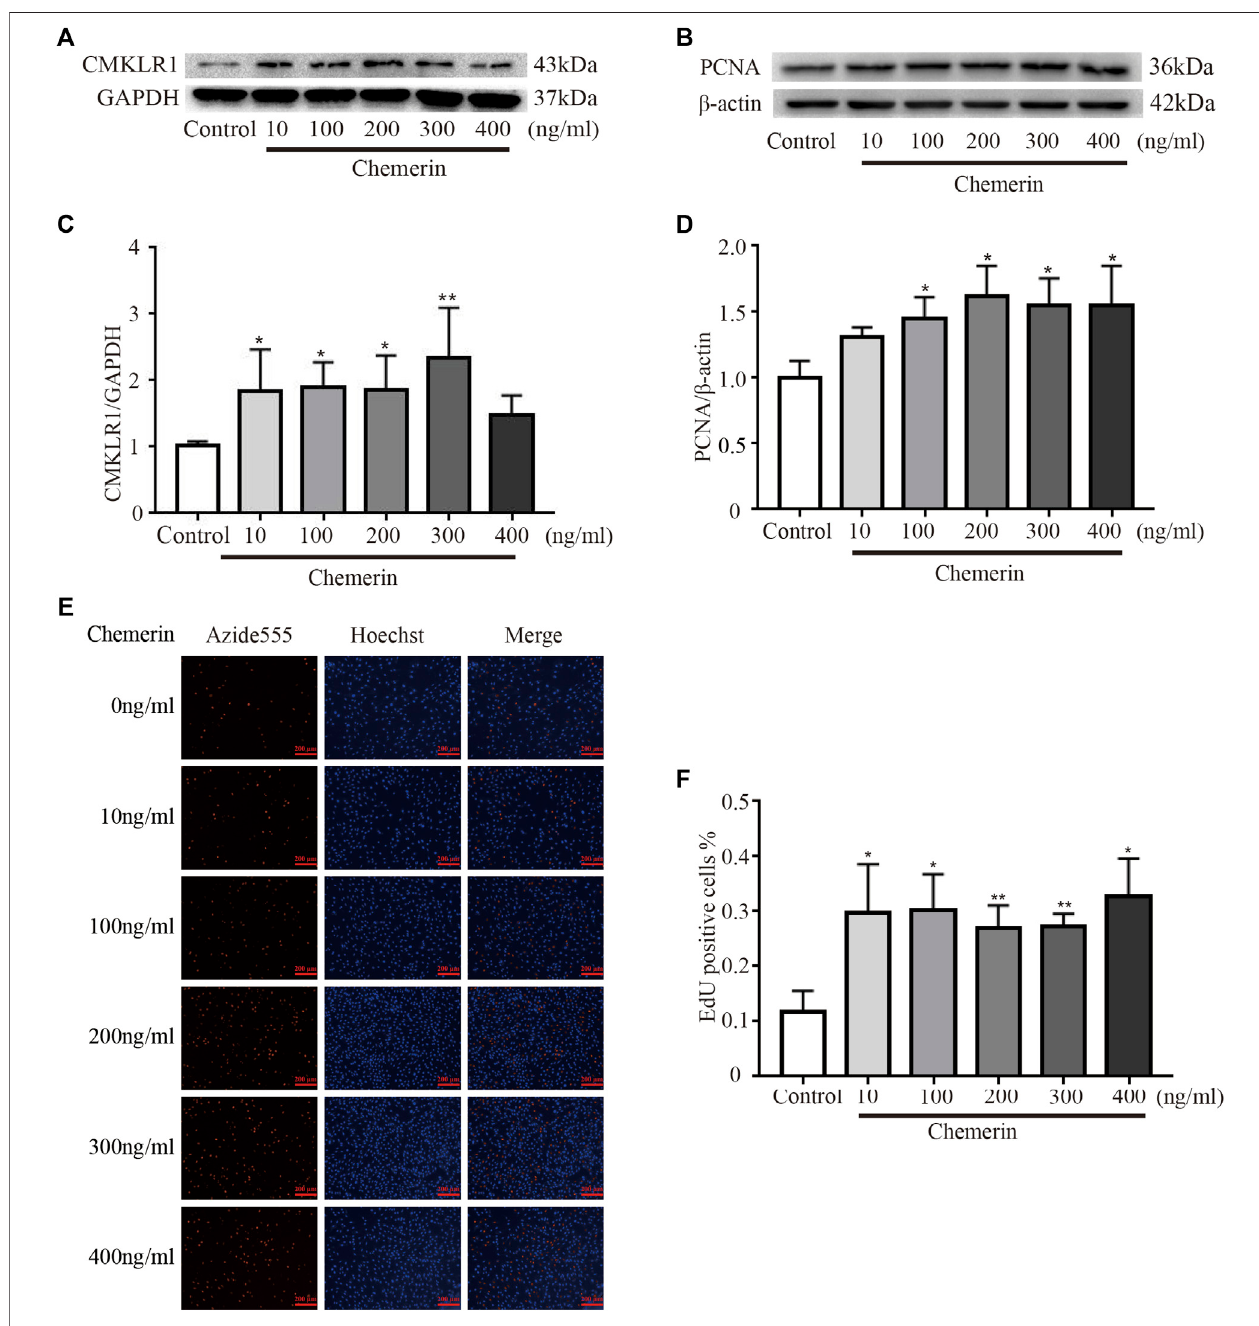
FIGURE 4 | Chemerin/CMKLR1 promotes the proliferation of PASMCs. PASMCs were stimulated with various concentrations of chemerin. (A – D) Western blot analysis of the expression of CMKLR1 (A and C) and PCNA (B and D) in PASMCs after 24 h of treatment. (E and F) PASMCs proliferation was measured by an EdU staining assay after 24 h of treatment. (original magni fi cation, ×100, scale bars, 200 μ m). * p ＜ 0.05 vs. the control group; ** p ＜ 0.01 vs. the control group.